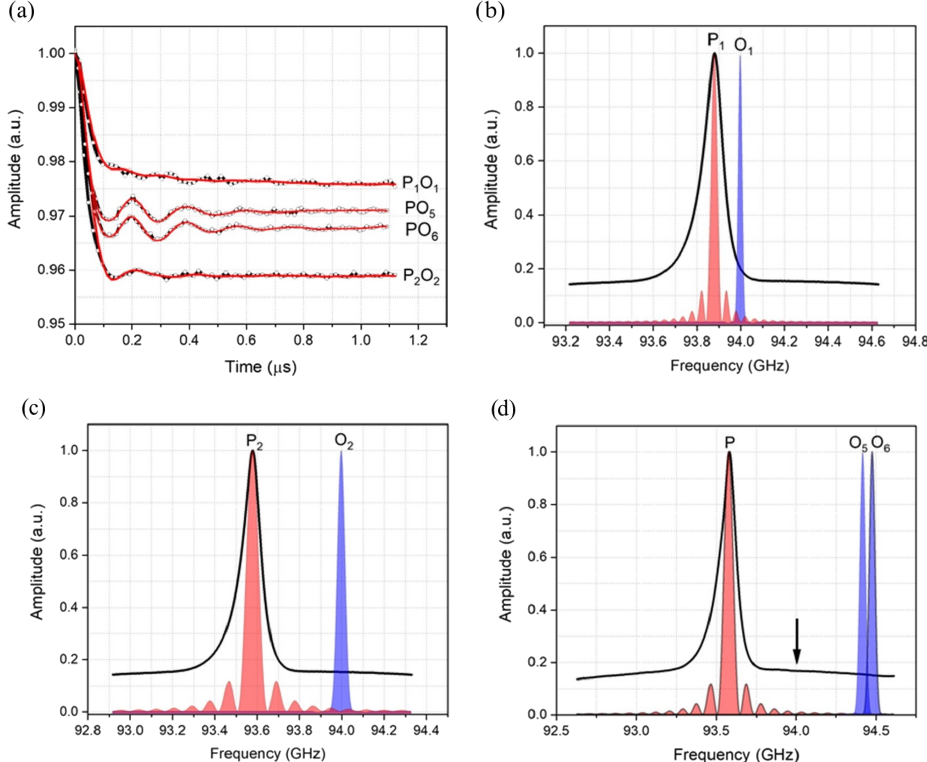
Figure 5. (a) Background-corrected DEER data (black curves) of Gd ruler (2.1nm) recorded with different offsets between pump and observer pulses together with fits (red curves) obtained by DeerAnalysis (2019) (Jeschke et al., 2006). (b, c, d) Excitation profiles of the pump (P) and observer (O) pulses at different frequency offsets. Please note the different frequency scales. The corresponding frequency offsets are P 1 O 1 = 120MHz, P 2 O 2 = 420MHz, PO 5 = 840MHz and PO 6 = 900MHz. The black arrow indicates the position of 94GHz, the nominal centre frequency of our W-band EIK amplifier, which has a bandwidth of just less than 1GHz.